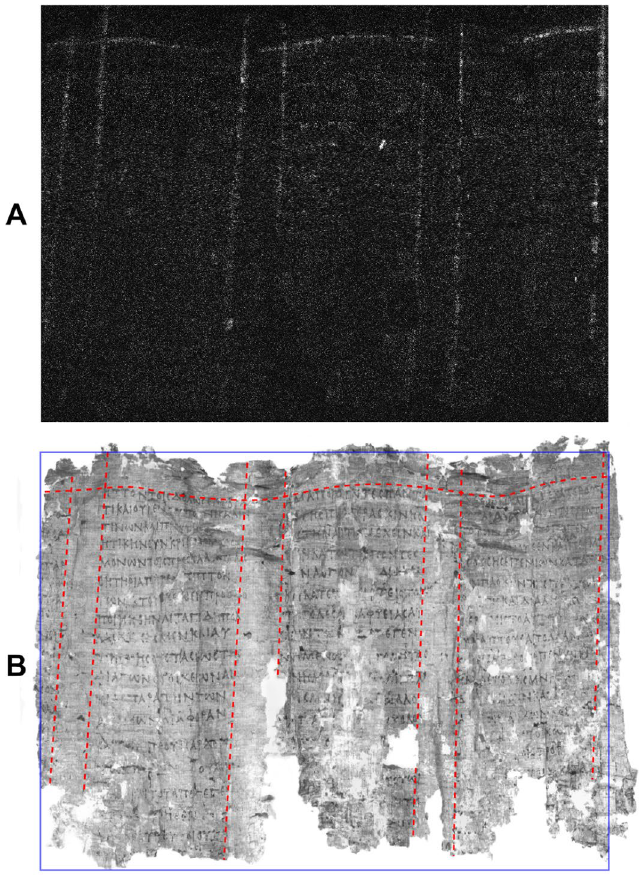
Figure 3. PHerc. 1420, ‘cornice’ 2. Pb distribution map obtained by MA-XRF scanning. By permission of the Ministero della Cultura (photo credit: Biblioteca Nazionale “Vittorio Emanuele III,”